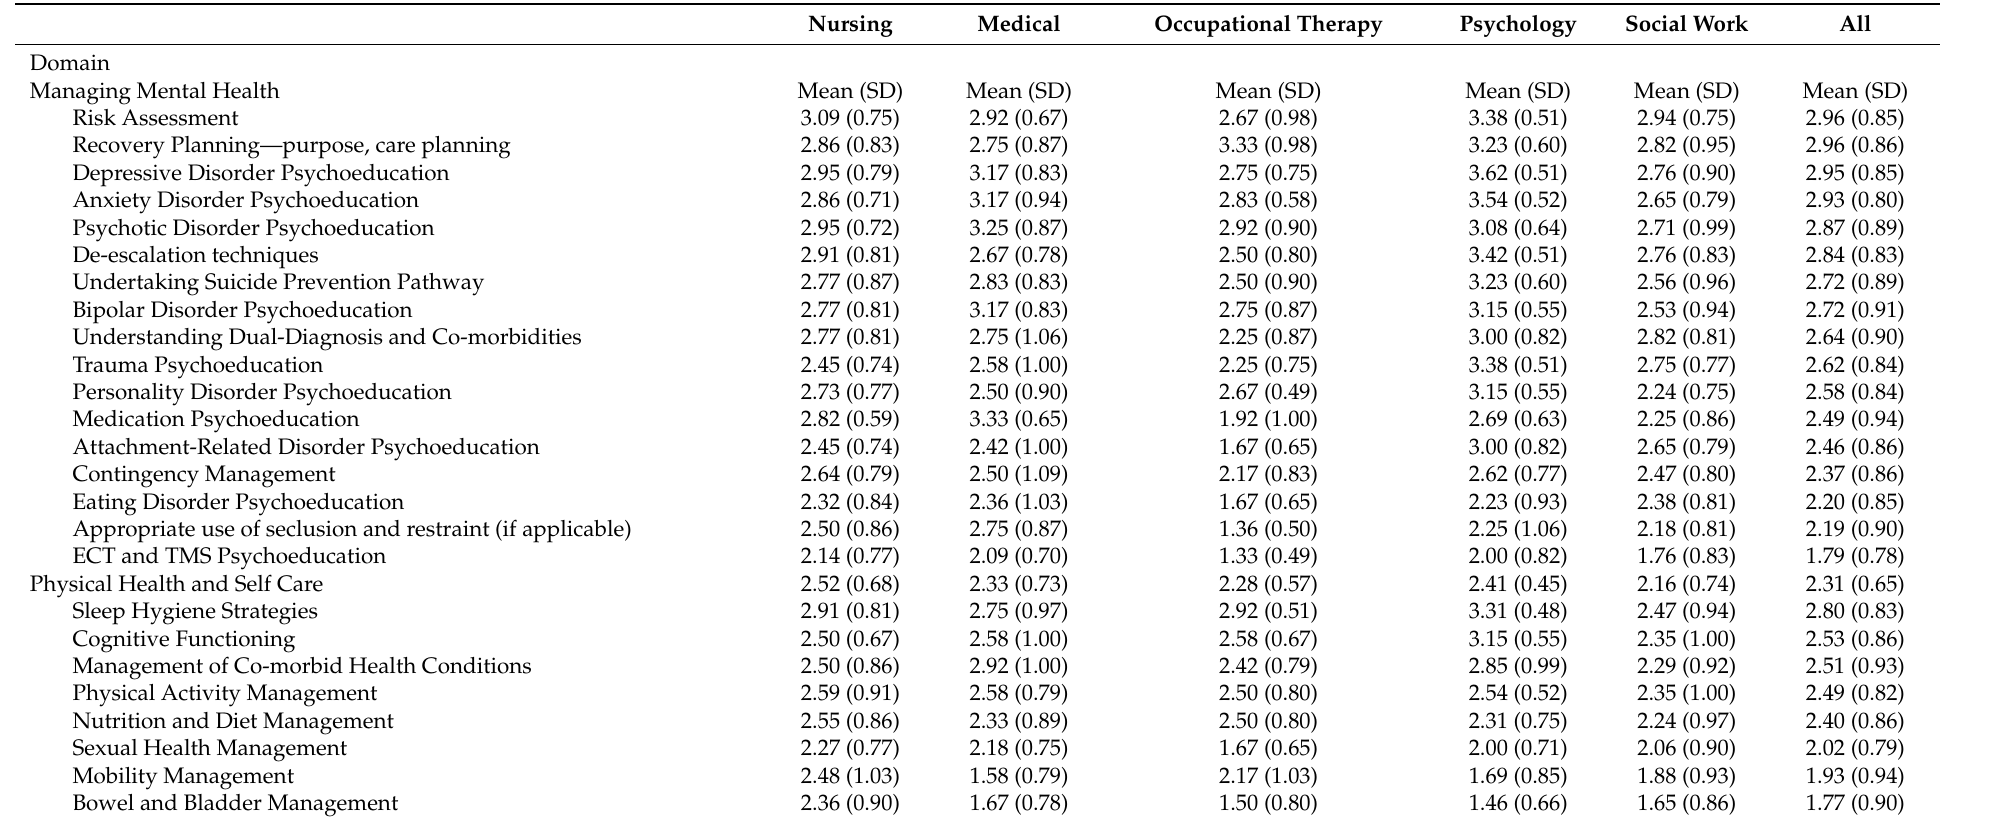
Table 1. Self-rated capability for Psychosocial Interventions Framework Assessment (PIFA) domains and interventions.